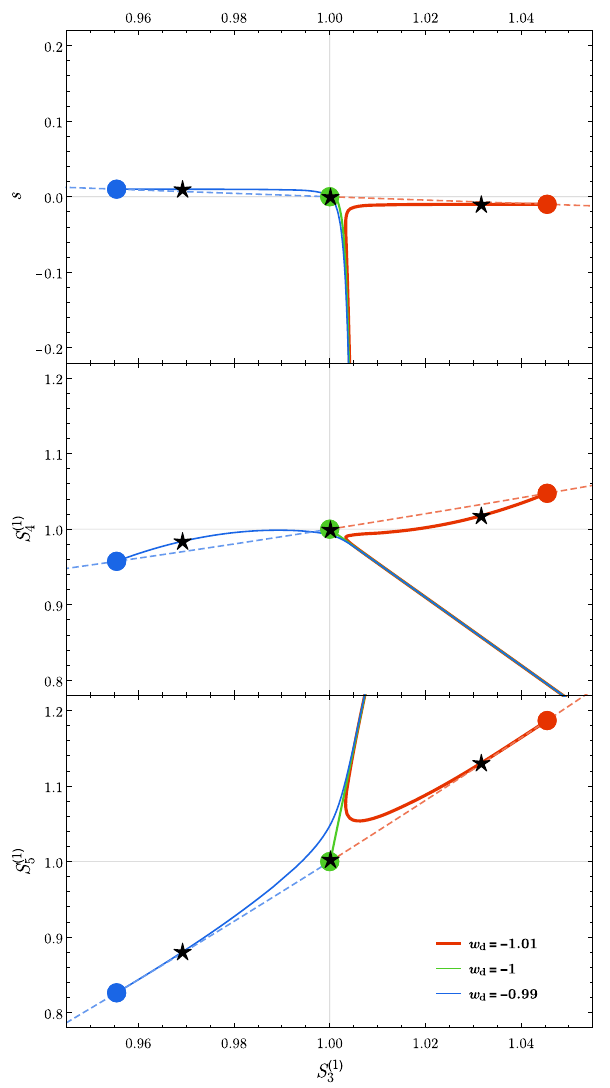
Fig. 1 This figure shows the trajectory of the three models considered ( 1 ) , s } , { S ( 1 ) , S ( 1 ) } and { S ( 1 ) , S ( 1 ) } planes, which in this work in the { S 3 3 4 3 5 characterise the statefinder hierarchy. The coloured points indicate the asymptoticvaluesofthestatefinderparametersaspresentedinEqs.(8)– (10). The dependence of these points on the deviation of w from the Λ CDM value − 1 is illustrated by the dashed lines. The black stars indicate the present day values of the statefinder parameters for each of the models